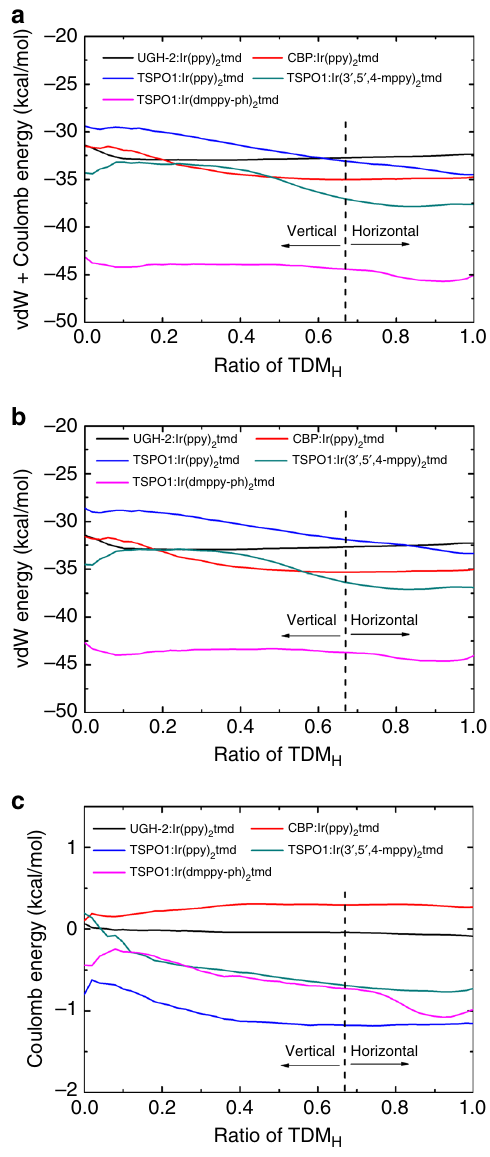
Fig. 5 Non-bonded interaction energies. a Calculated non-bonded van der Waals and Coulomb interaction energies with the cut-off radius of 0.9 nm of each atom of the phosphors as a function of TDM H in the fi ve host – dopant systems. b Van der Waals and c Coulomb interaction energies are Non-bonded interaction energy is calculated as a summation of van der Waals and Coulomb interaction energies from the MD simulation to investigate if the intermolecular interaction between the phosphor and neighbor host molecules is responsible for the spontaneous molecular alignments of the phosphors on the surfaces. Figure 5a depicts the correlation between non-bonded interaction energy and orientation of the emitting dipole moment of the phosphors in the fi ve different host-dopant systems. Distributions of the non-bonded interaction energy are given in Supplementary Fig. 7. There is a broad energy trap of ~3 kcal/mol in the region of TDM H = 0.1 − 0.5 for Ir(ppy) 2 tmd on the UGH-2 host and the energy increases with further increasing of TDM H , thereby resulting in rather a vertical EDO compared to random orientation because the population of TDM H is expected to be concentrated in the regions of low (large) non-bonded interaction